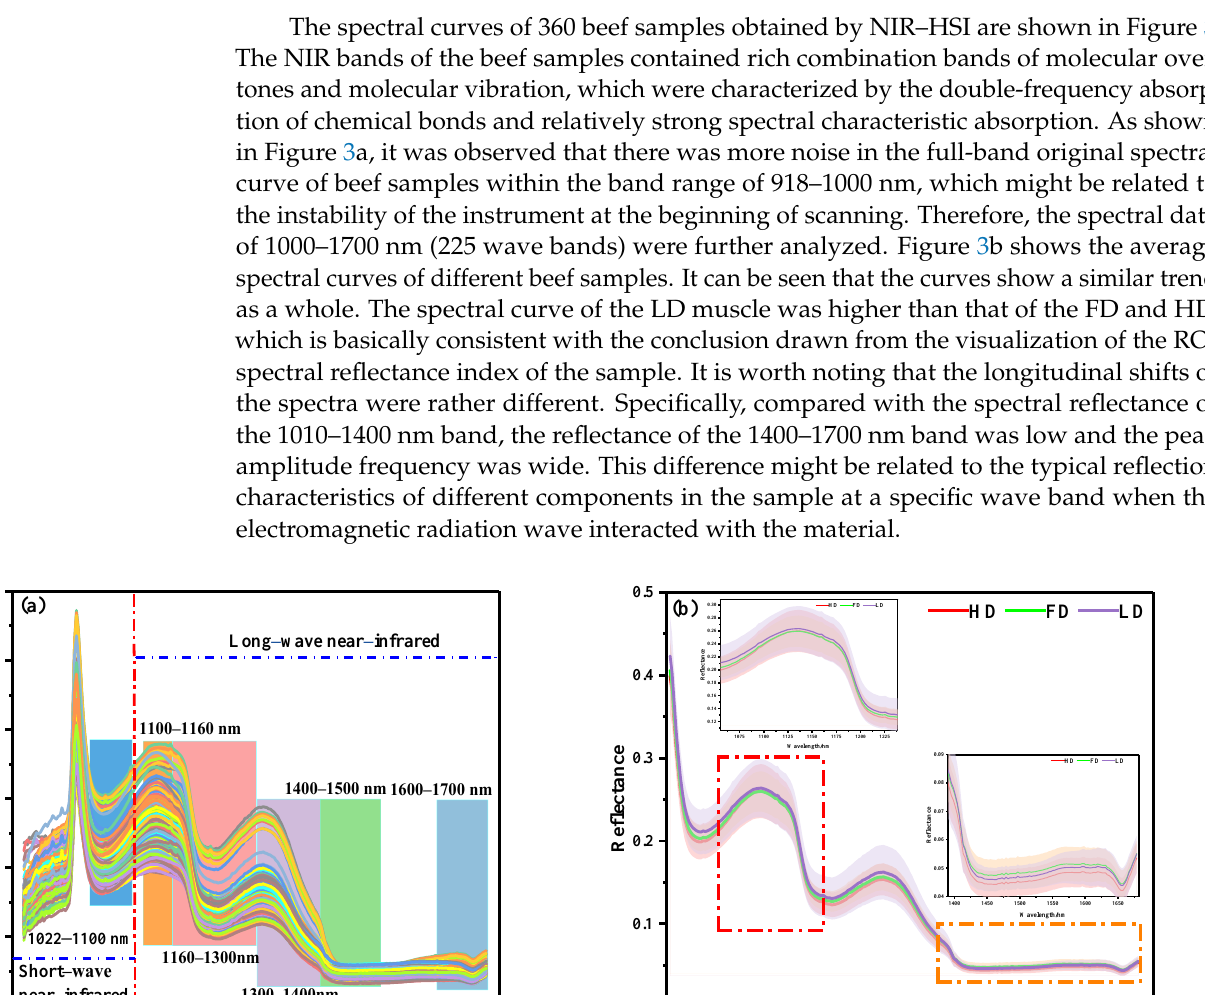
Figure 2. Visualization of spectral reflectance index of beef samples from different parts: ( a ) FD, ( b ) LD, and ( c ) HD.